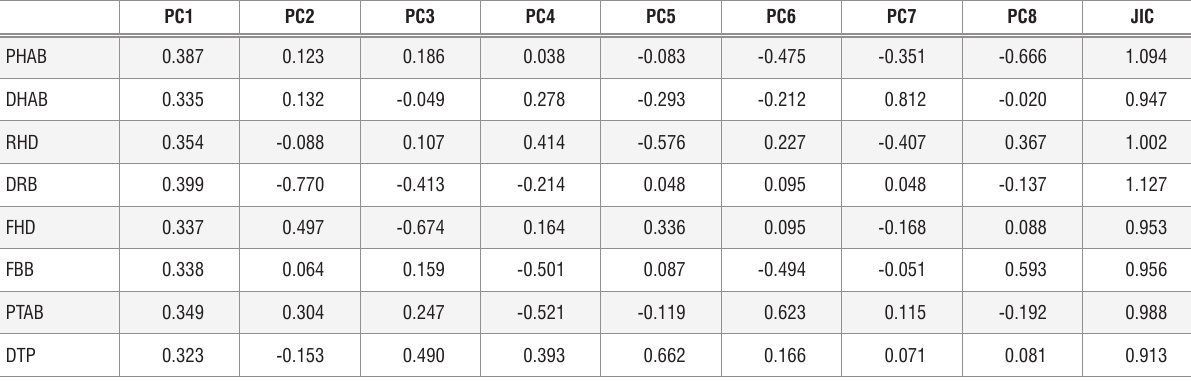
Component loadings for principal components (PC) analysis axes: Pan t.